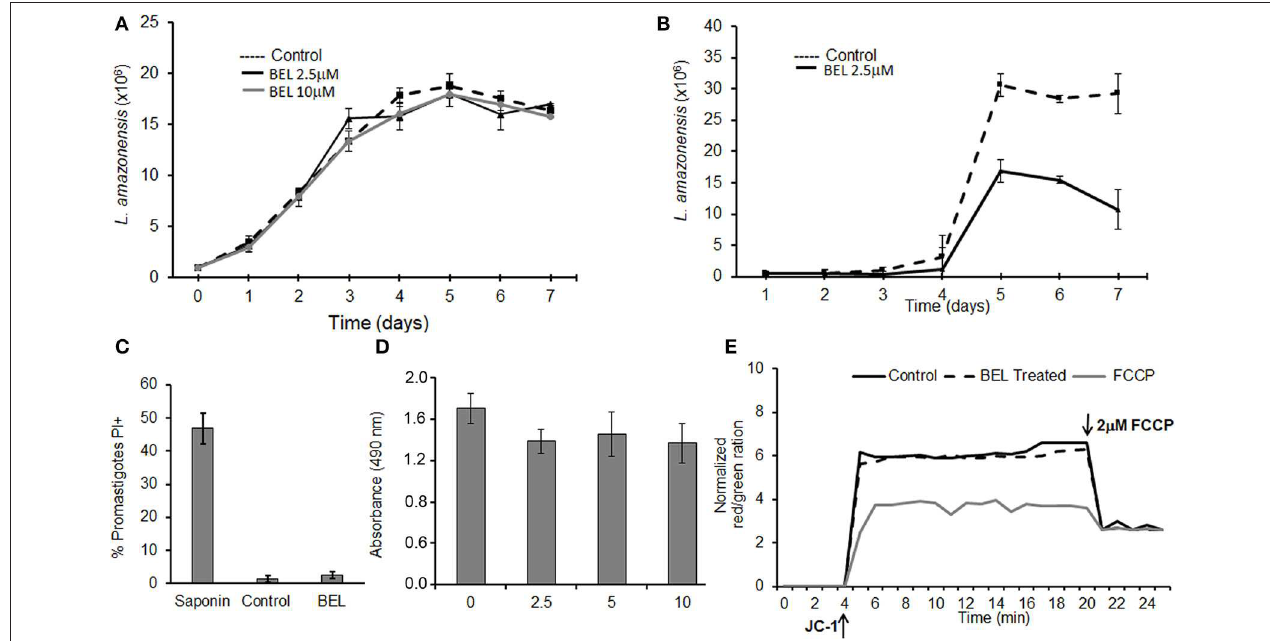
FIGURE 1 | Effects of bromoenol lactone (BEL) on Leishmania amazonensis . (A) Promastigotes were grown in the absence (control) or presence of 2.5 or 10 µ M BEL, and cells counted daily for 7 days, using a hemacytometer. (B) L. amazonensis metacyclogenesis, Log growth phase promastigotes were incubated with 2.5 µ M BEL and the percentage of metacyclic forms were evaluated daily over 7 days of growth using a hemocytometer. (C) Flow cytometry analysis of untreated control and BEL-treated promastigotes (2.5 µ M, 1h, 26 ◦ C) stained with 15 µ g/mL propidium iodide (PI). Saponin treated-parasites were used as a positive control. (D) Untreated (0) and BEL-treated promastigotes at the indicated concentrations were stained with MTS/PMS for the viability assay. (E) Mitochondrial membrane potential ( 19 m ), in cells labeled with JC-1. The values of 19 m were evaluated over 20min, after which the “uncoupler” carbonyl cyanide-4-phenylhydrazone (FCCP) was added to the incubation medium, to abolish the 19 m . The 19 m values are expressed as the ratio of aggregate [red]/monomer [green] measured at 590/530nm. Data represent mean ± SEM values from three independent experiments, performed in triplicates.